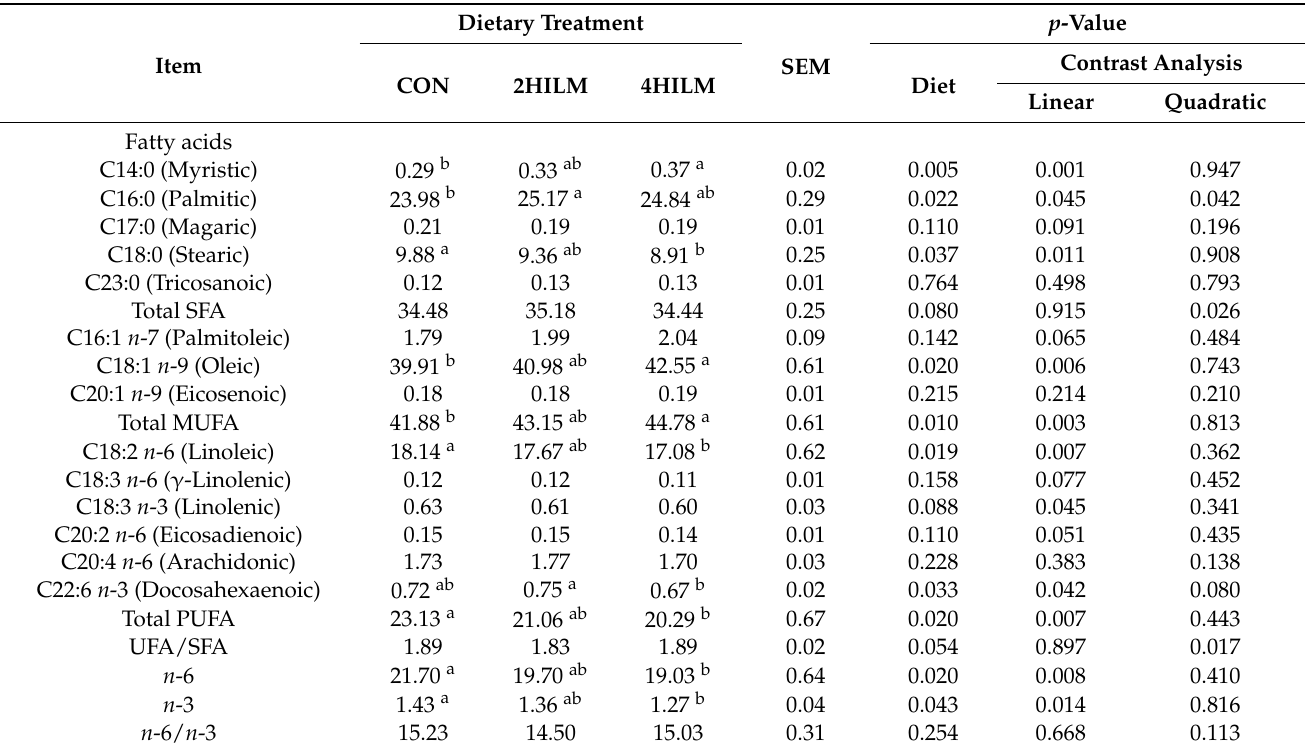
Table 7. Effect of the dietary Hermetia illucens larvae meal (HILM) inclusion level on the fatty acid profile (percentage of total fatty acid methyl esters) of laying hen eggs.